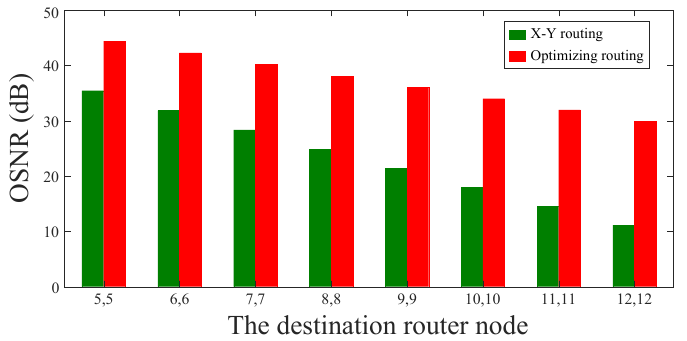
Figure 12. OSNR comparison of the longest optical links in different optical network